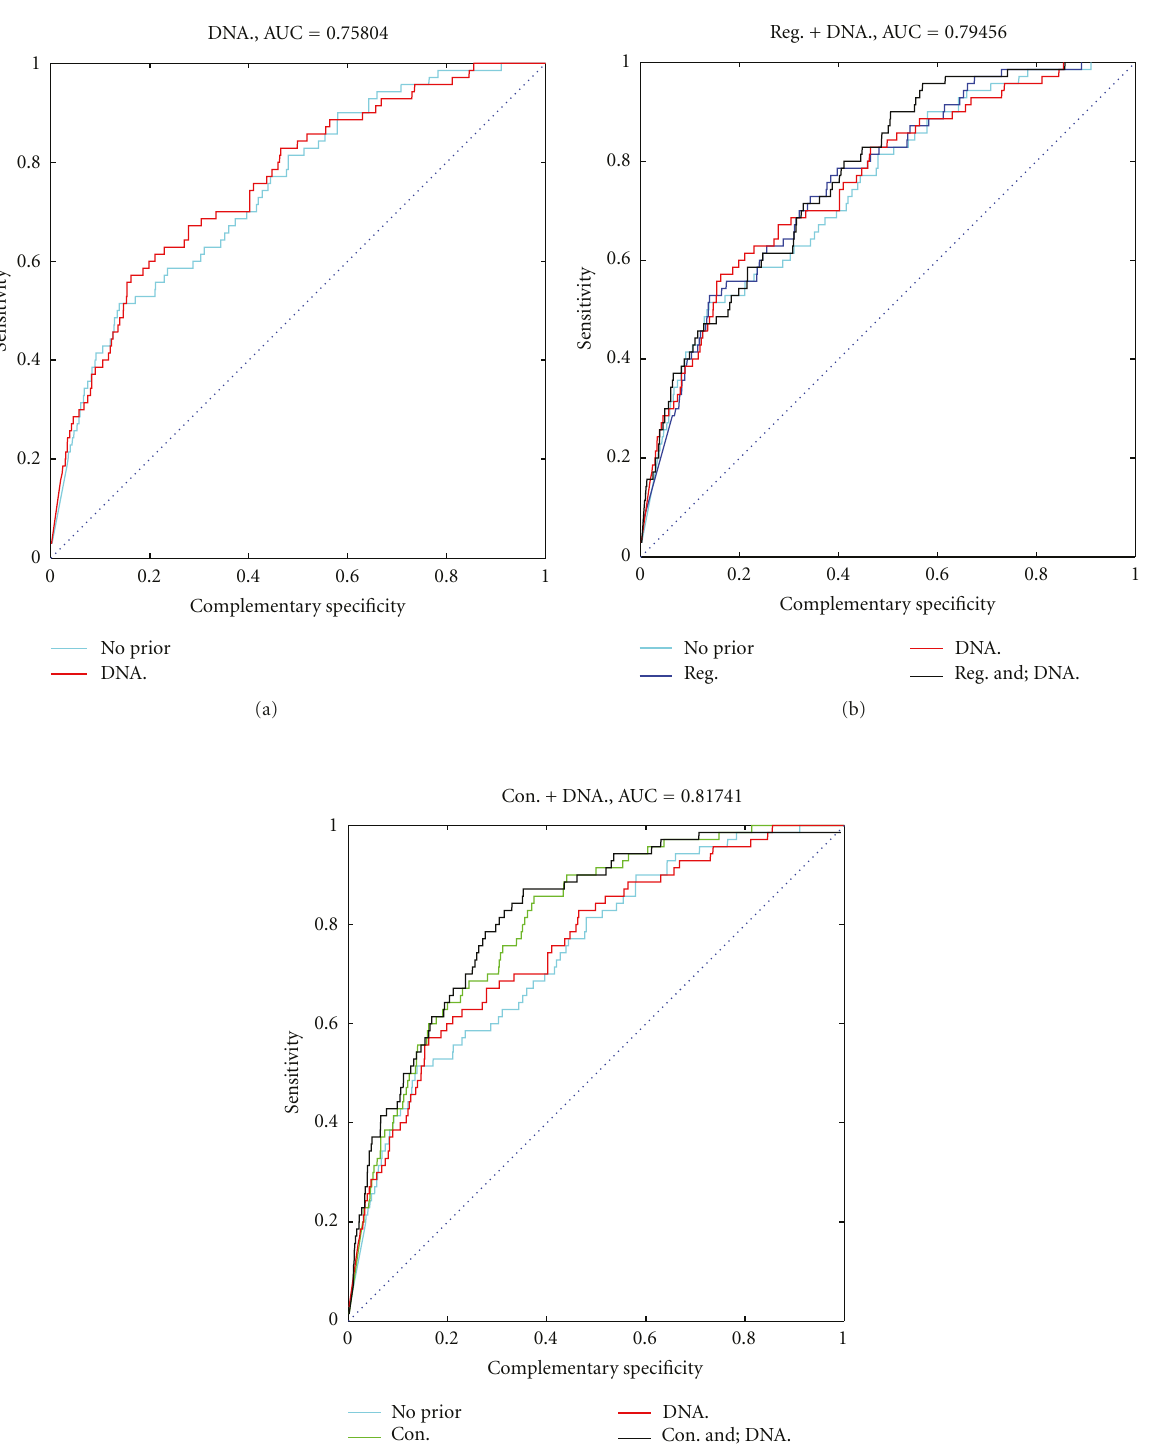
Figure 4: ROC curves for incorporating DNA duplex stability data. ROC curves of the estimated binding probabilities for the proposed data fusion method when combined with (a) DNA duplex stability data, (b) DNA duplex stability data and regulatory potential, and (c) DNA duplex stability data and evolutionary conservation